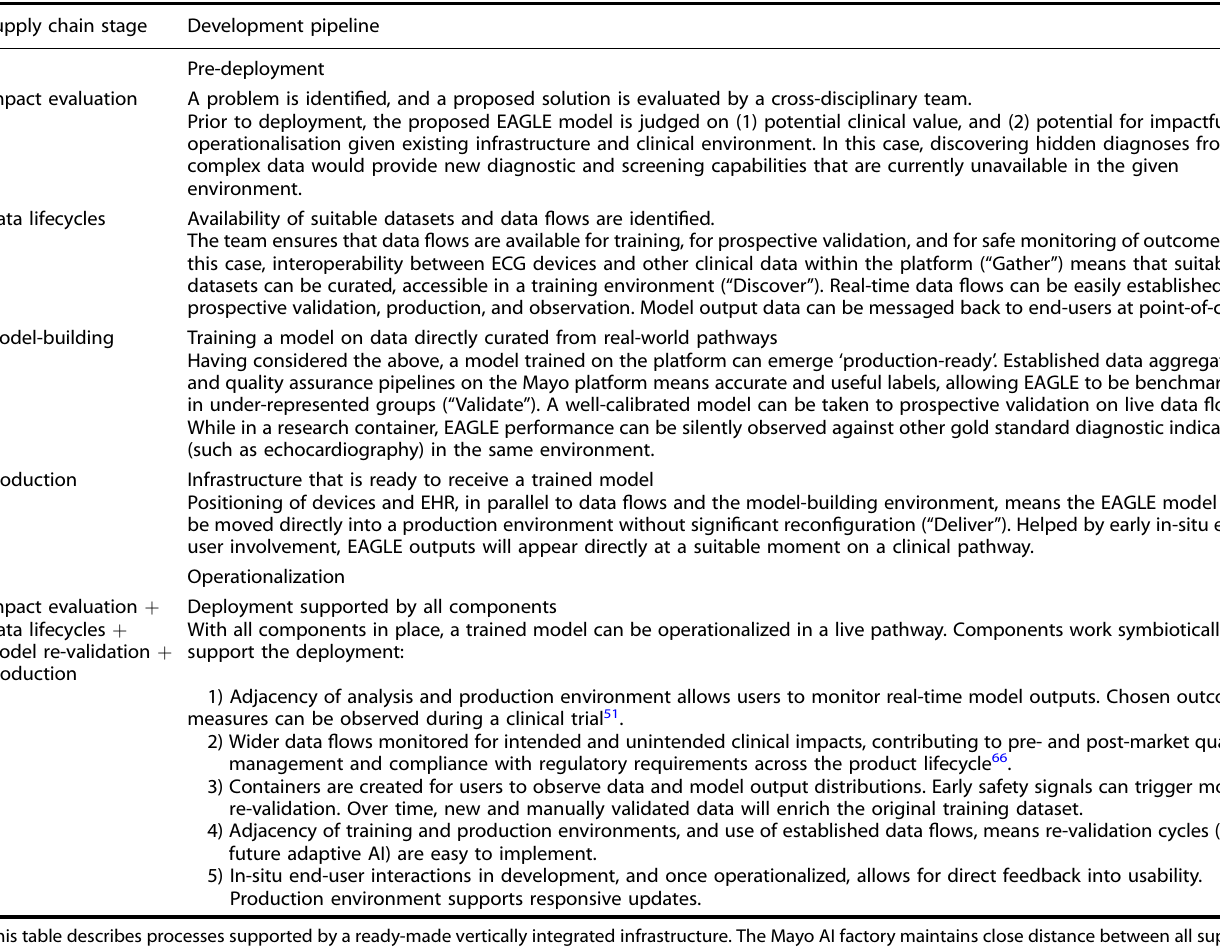
Table 1. Pre-deployment and operationalization on Mayo platform of ECG AI-Guided Screening for Low Ejection Fraction